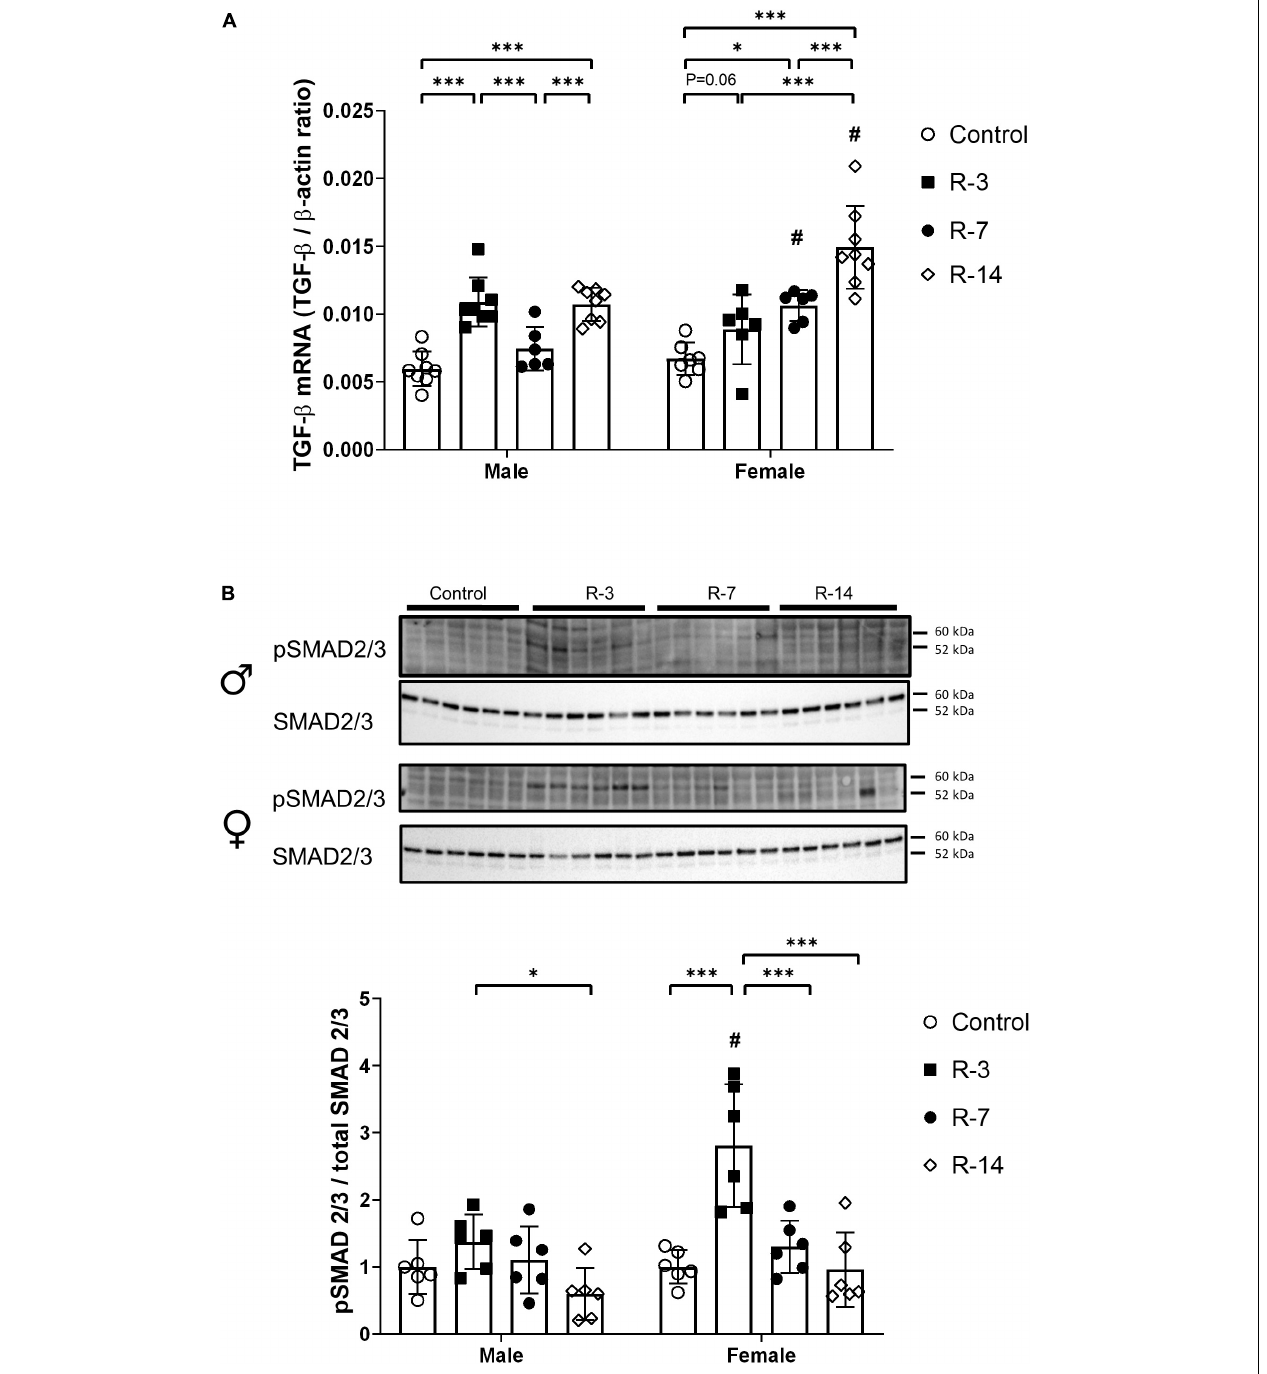
FIGURE 5 | Activation of the TGF- β /SMAD2/3 signaling after release of 24 h total bladder outlet obstruction. (A) TGF- β mRNA expression was increased in male mice at 3 and 14 days post release, with a drop to control levels at 7 days post release. In female mice, TGF- β mRNA expression was significant increased at 7 and 14 days post release. The male mice showed a lower TGF- β mRNA expression in the R-7 and R-14 groups compared with the female R-7 and R-14 groups, respectively. Relative mRNA expression was calculated using the reference gene β -actin ( n = 8, 8, 6, and 8 in the male control, R-3, R-7, and R-14 group, respectively; n = 7, 6, 6, and 8 in the female control, R-3, R-7, and R-14 group, respectively). (B) Representative Western blots related to SMAD signaling showing no activation of SMAD2/3 during the observation period in the male mice. Increased phosphorylation of SMAD2/3 were observed in the female mice at 3 days post release, then back to control level at 7 and 14 days post release. The pSMAD 2/3 of female R-3 group was higher than the male R-3 group. pSMAD 2/3 was normalized by total SMAD2/3. Quantification of protein expression relative was normalized by total protein ( n = 6 in all groups). as means ± SD. ∗ P < 0.05 and ∗∗∗ P < 0.01. # P < 0.05 compared between genders with the corresponding